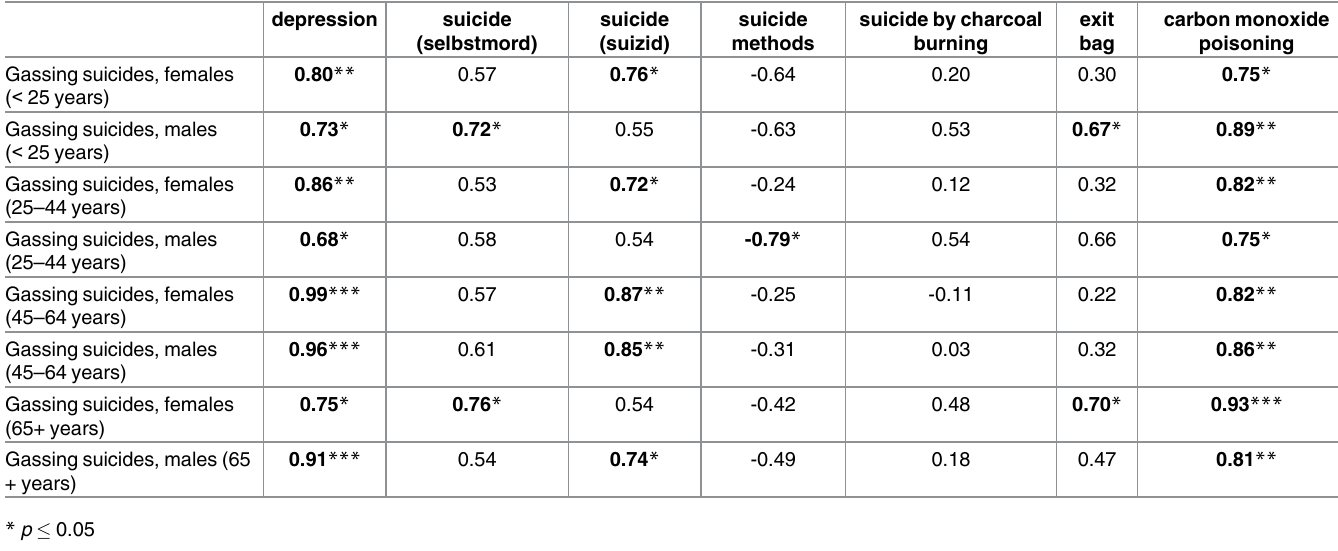
Table 2. Pearson correlations between annual frequencies of Google searcheswith suicides in Germany,